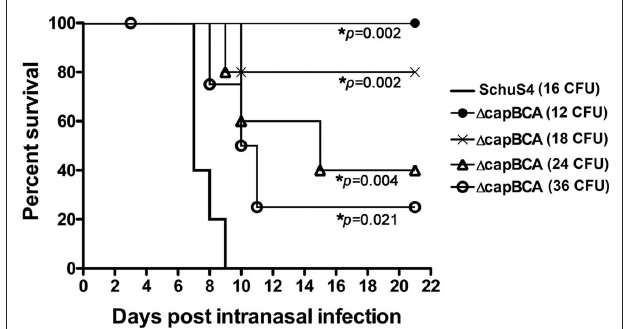
Figure 2 | Contribution of capBCA to the virulence of type A F. tularensis . BALB/c mice ( n = 5) were intranasally infected with the indicated doses of Schu S4 or isogenic ∆ capBCA mutant ST965. Survival was monitored for 21 days. The results are expressed as Kaplan–Meier curves and p values determined using log-rank test. The data shown are a representative of two